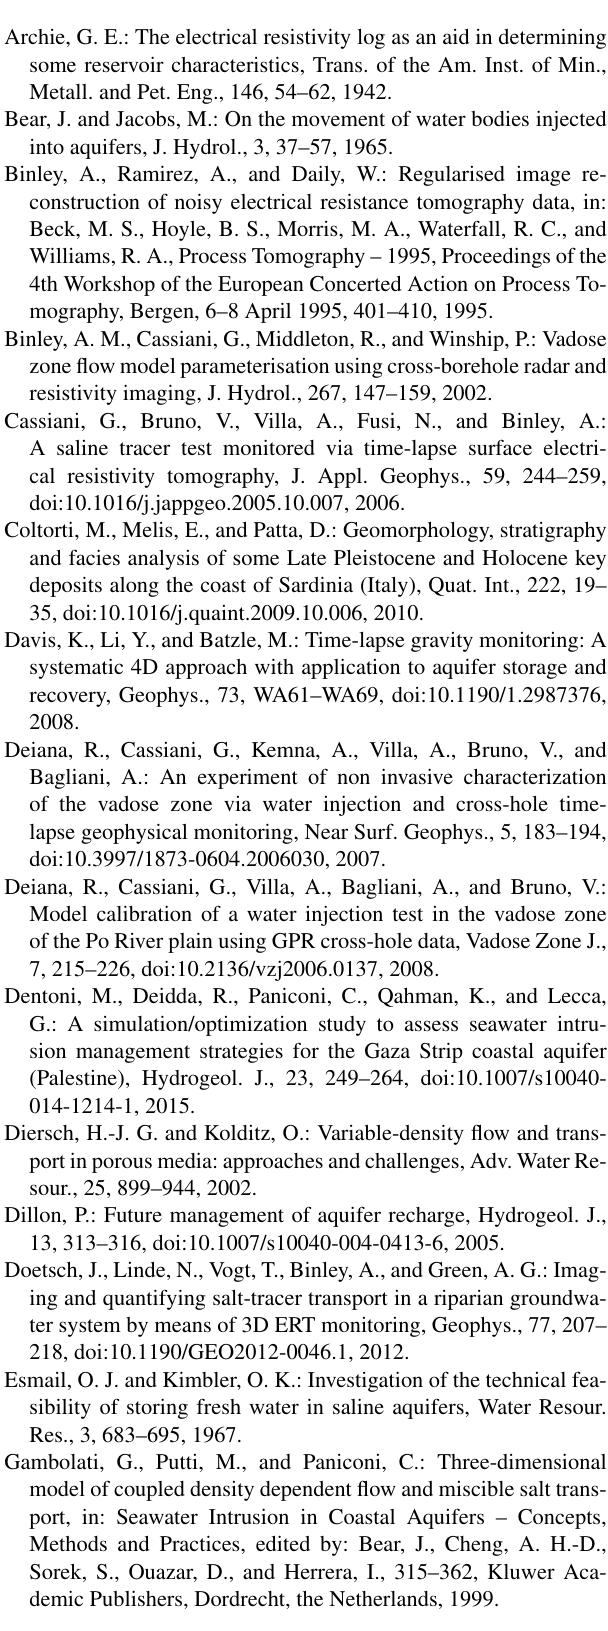
figurations for quick measurements (e.g., in the condi- tions represented in this study an acquisition time of less than 30 min is